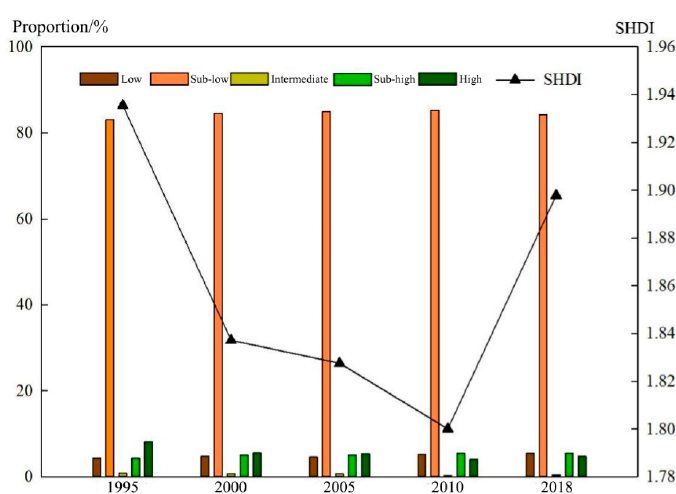
Figure 4. Area proportion of each level of IESV from 1995–2018.